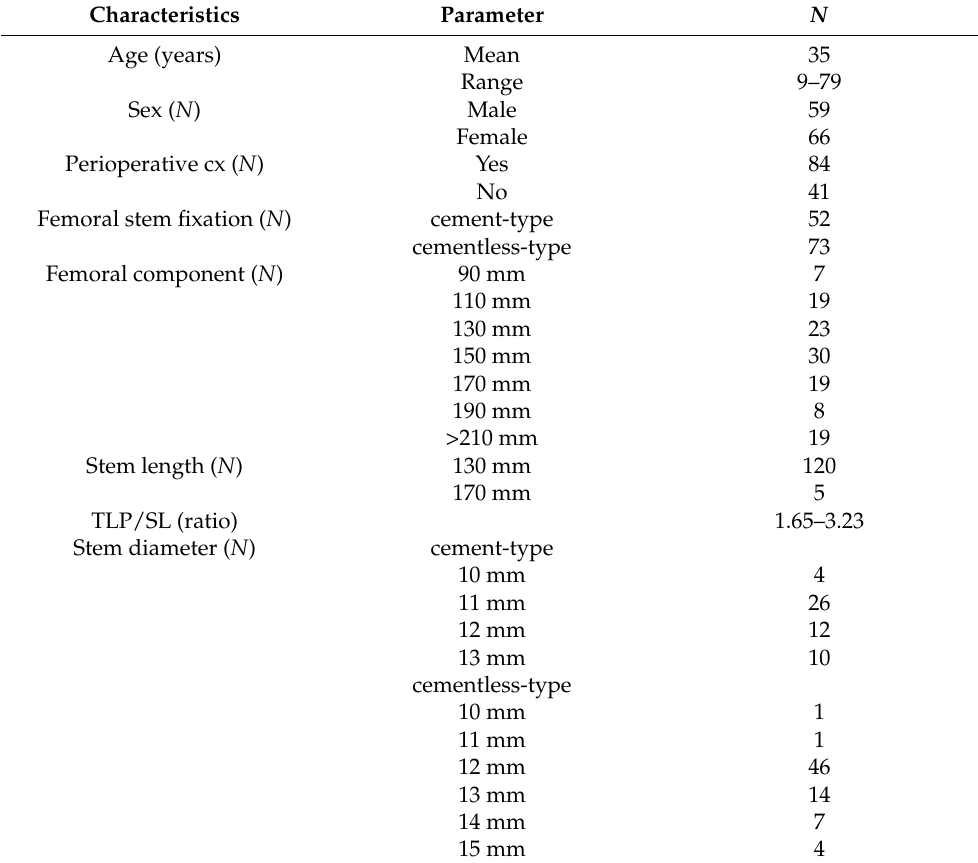
Table 1. Patient